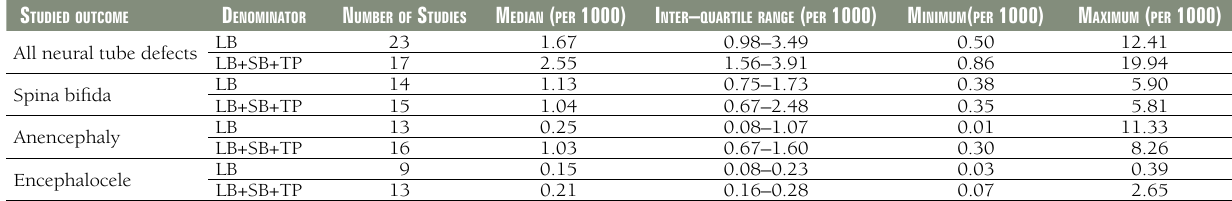
Table 3. A summary of estimates of the burden of neural tube defects and its sub–types from 37 retained studies from low and middle–income countries